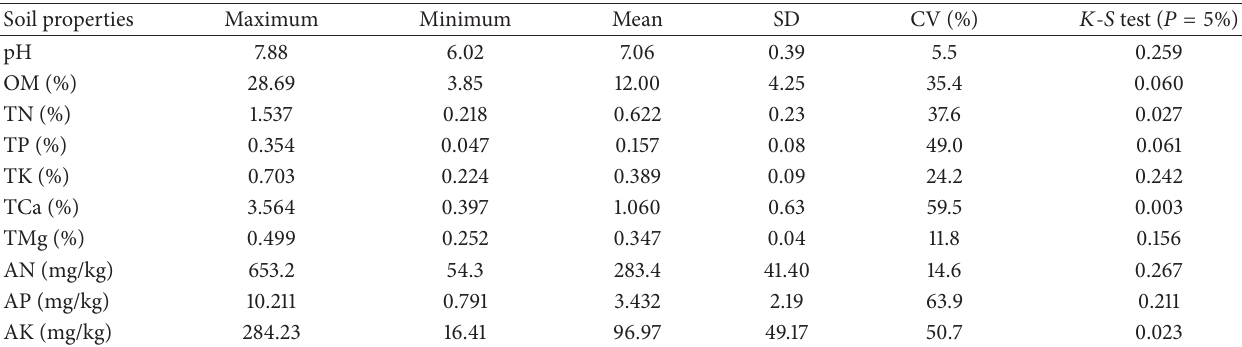
Table 1: Descriptive statistics for soil chemical properties.